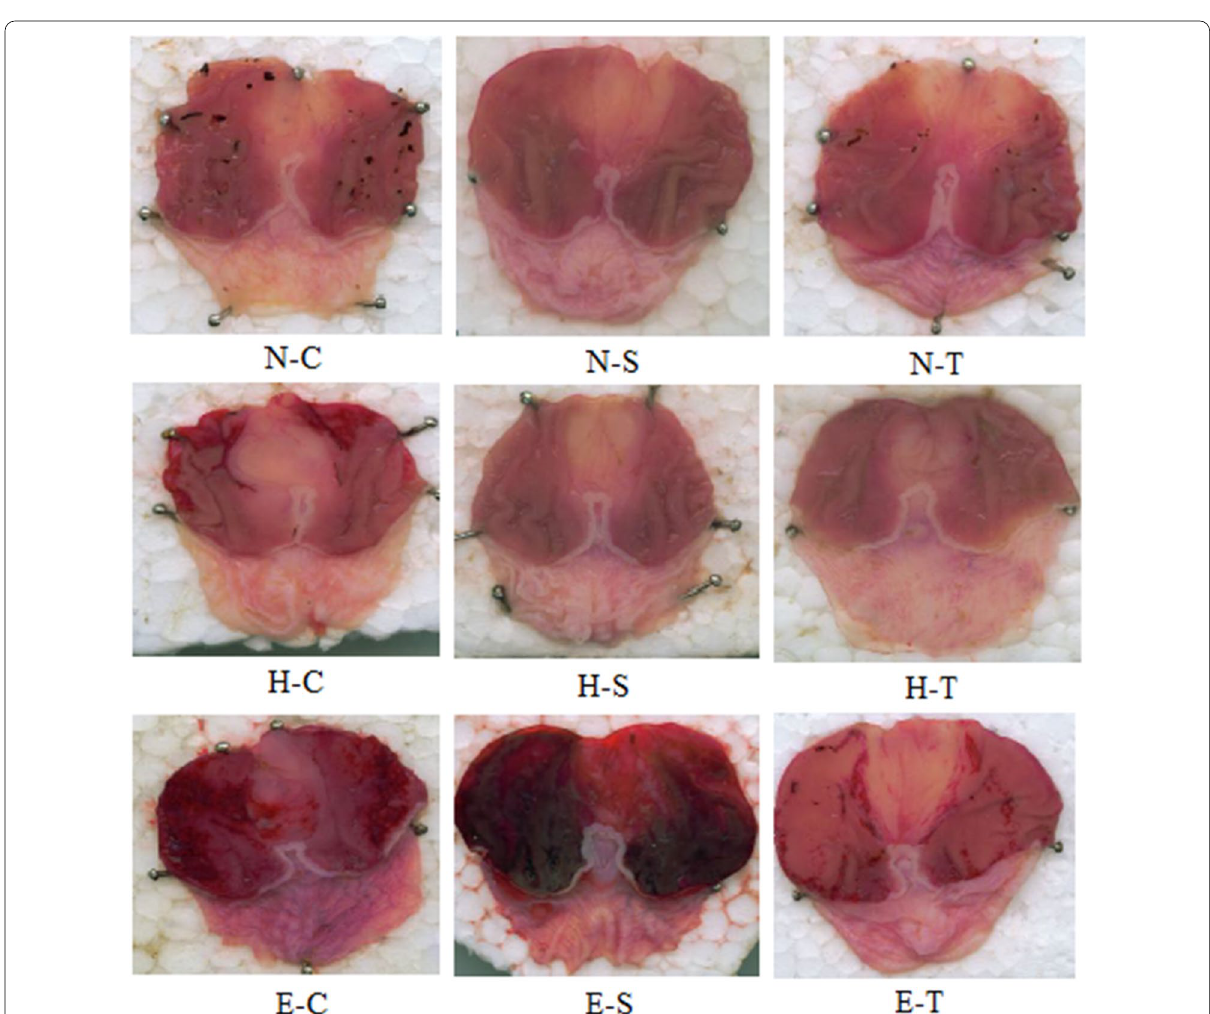
Fig. 3 Morphological changes due to administration of C. zeylanica extract in different experimental models of ulcers. N-C Naproxen-treated control group, N-S naproxen-treated standard group, N-T naproxen-treated test group, H-C histamine-treated control group, H-S histamine-treated standard group, H-T histamine-treated test group, E-C ethanol-treated control group, E-S ethanol-treated standard group, E-T ethanol-treated test